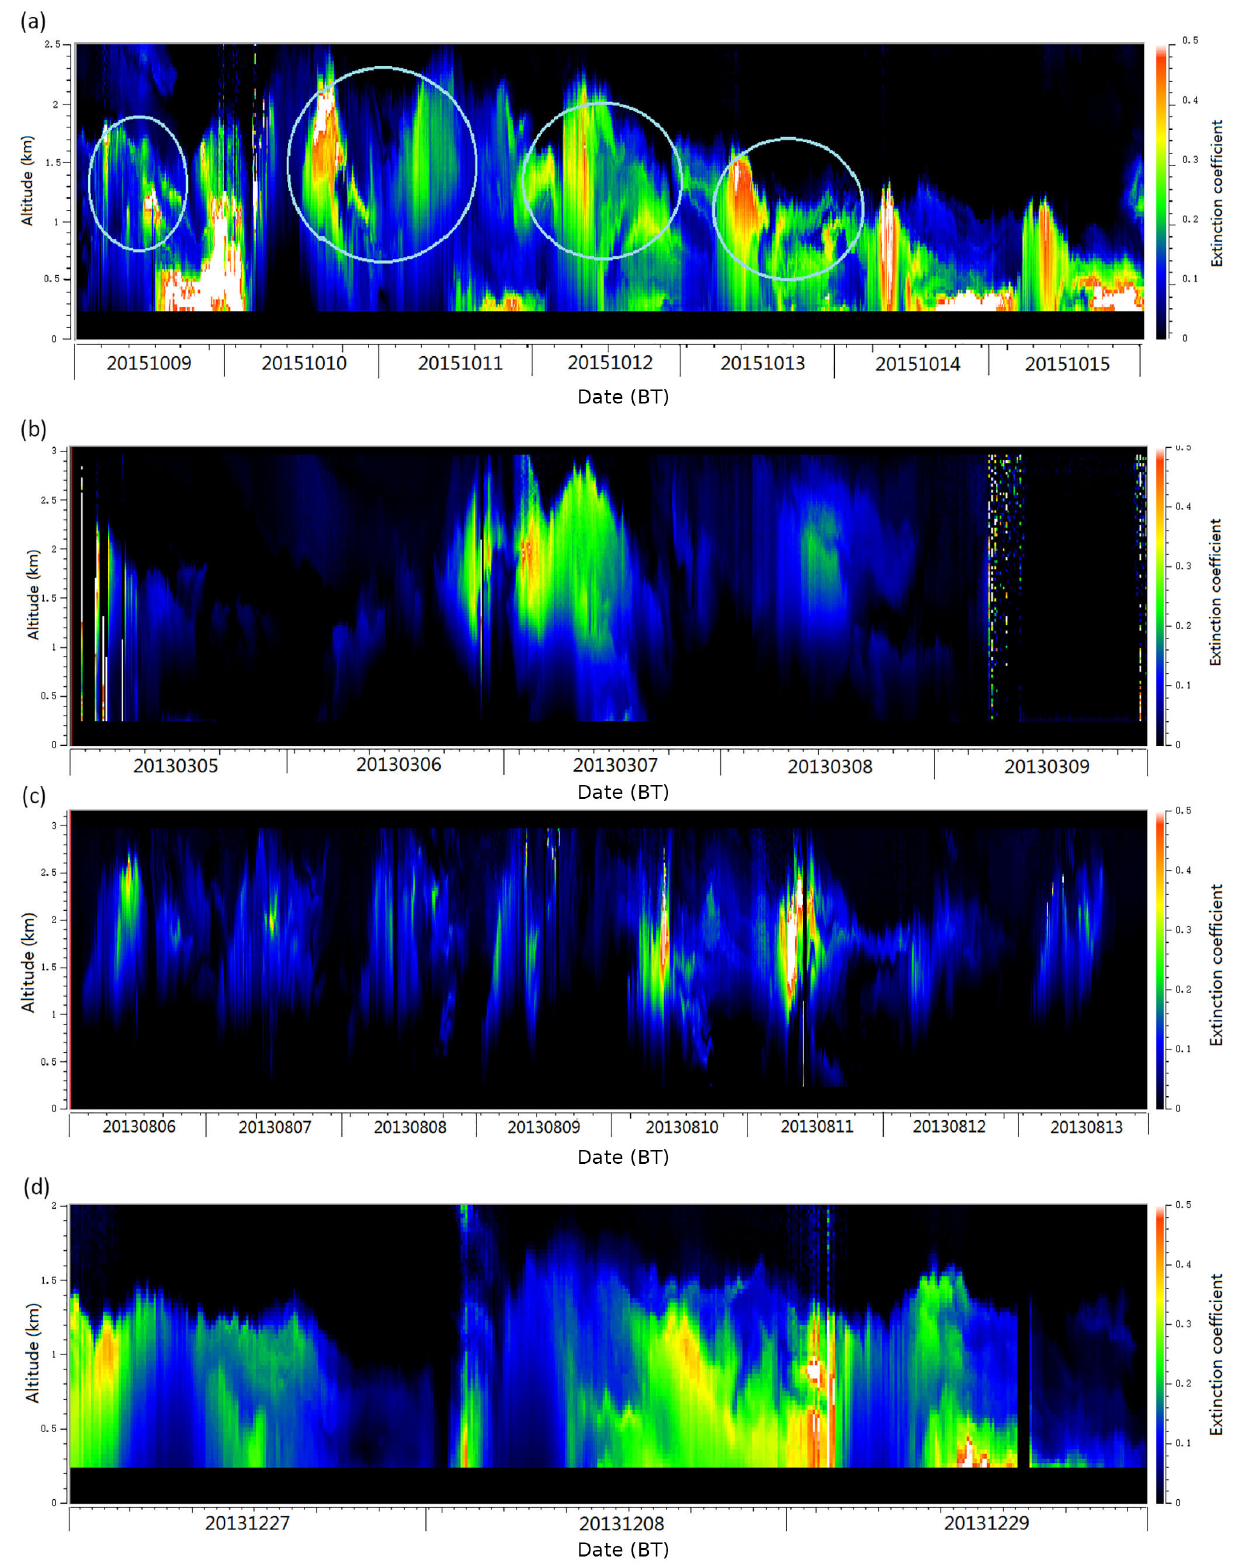
Figure 4. Time–height cross section of the ground-based lidar-derived extinction coefficient at 532nm in Hangzhou during (a) 9–15